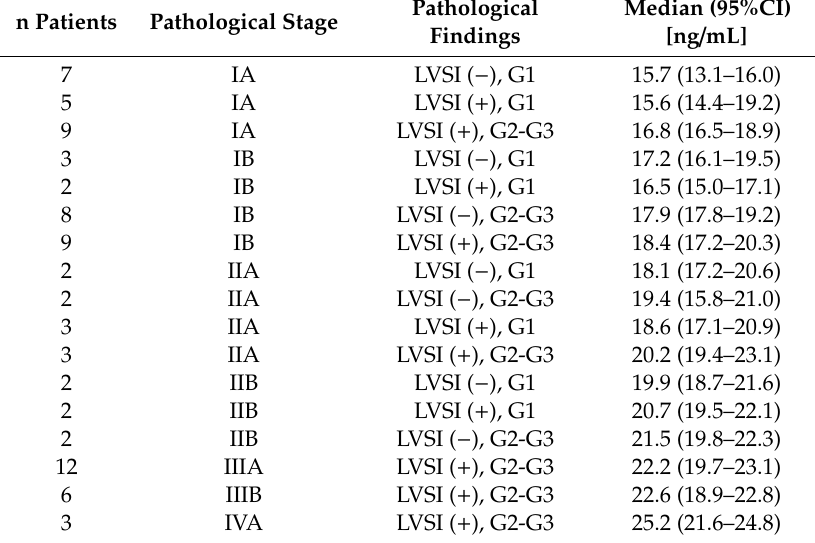
Table 4. Relationship between galectin 3 serum concentration and pathological stage and findings. n